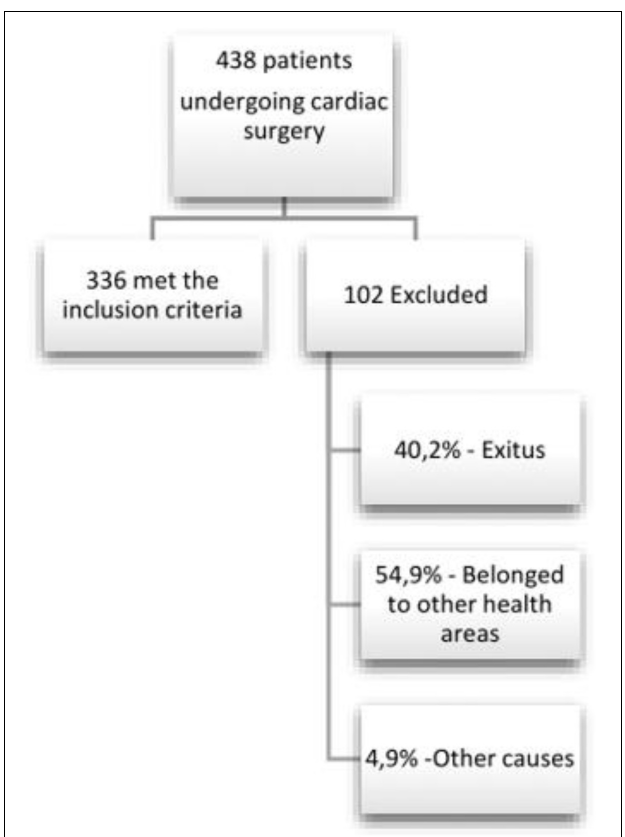
FIGURE 1 | Flow chart of study design.